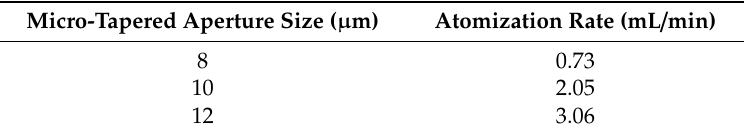
Figure 12. Relationship between the atomization rate and micro-tapered aperture size. Table 4. Atomization rate of di ff erent micro-tapered aperture sizes.